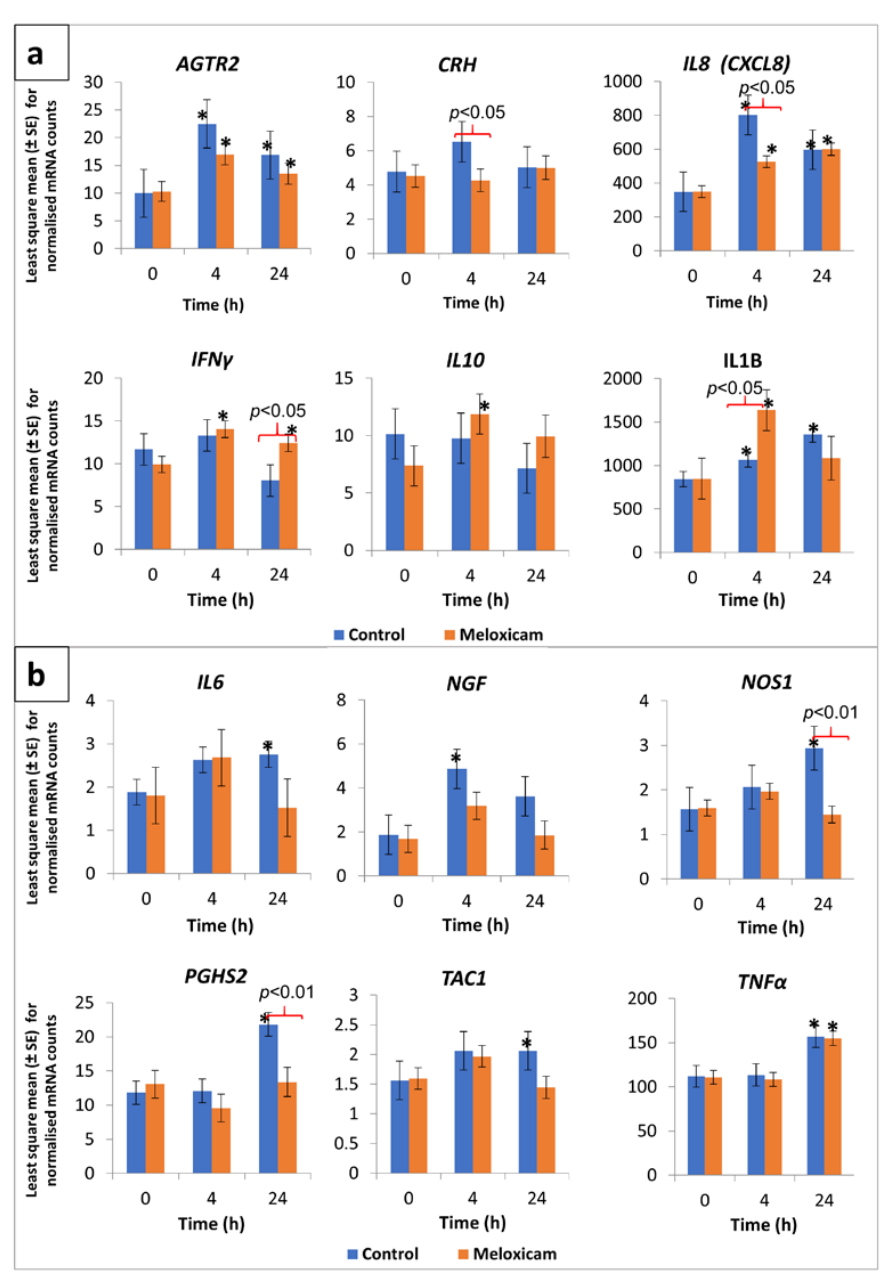
Figure 1. Transcription profile of selected cytokine and neuroactive ligand-receptor genes in peripheral leukocytes from calves, in response to cautery disbudding. Two groups of calves (aged 31 to 41 days, n = 8 per group), that were either administered meloxicam or no analgesic (control), were disbudded using an electric debudder. mRNA counts in peripheral leukocytes, as determined by amplification-free nCounter gene expression assay (NanoString, Seattle, WA, USA), were normalised based on the RNA counts of three reference genes included in the assay. An asterisk (*) over the mean bars indicates a significant (p < 0.05) difference of transcription compared with respective pre-disbudding mean, within treatment, while significant differences between the treatment and control group means, within each time point, were denoted with braces and respective p-values on top of the bars. ( a ) Data pertaining to angiotensin II receptor type 2 (ATGR2), corticotropin-releasing hormone (CRH), interleukin 8 (IL8), interferon gamma (IFNγ), interleukin 10 (IL10), and interleukin 1 beta (IL1B) are shown in this graph. ( b ) Data pertaining to interleukin 6 (IL6), nerve growth factor (NGF), nitric oxide synthase 1 (NOS1), prostaglandin-endoperoxide synthase 2 (PGHS2), tachykinin precursor 1 (TAC1), and tissue necrosis factor α (TNFα) are shown in this graph.